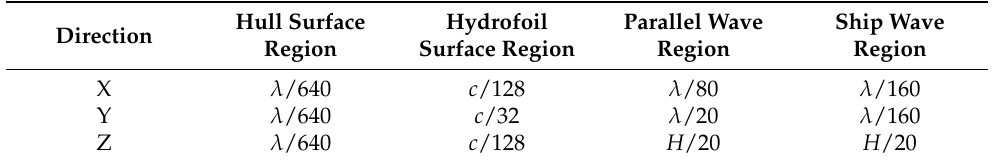
Figure 4. Top view of local successive refinement of the grid near the free surface. Table 2. The refined mesh size of different regions.